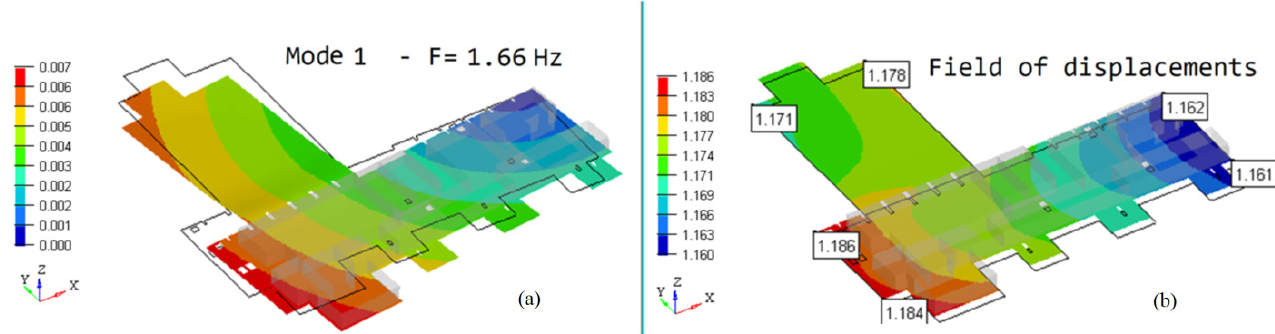
Figure 12. ( a ) Eigenmode 1; ( b ) distribution of transmissibility in different points to a harmonic excitation with the 1st eigenfrequency after the OY axis.